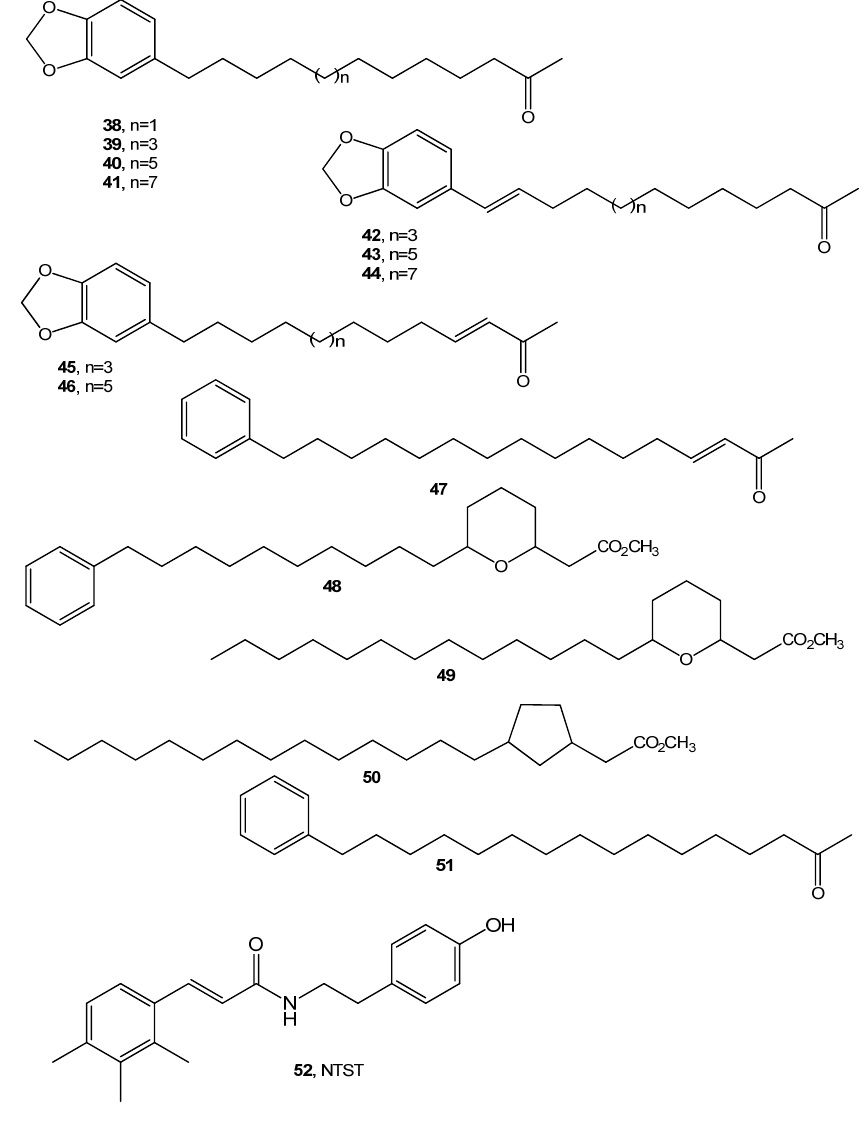
Figure 4. The structures of compounds 38 – 52 .